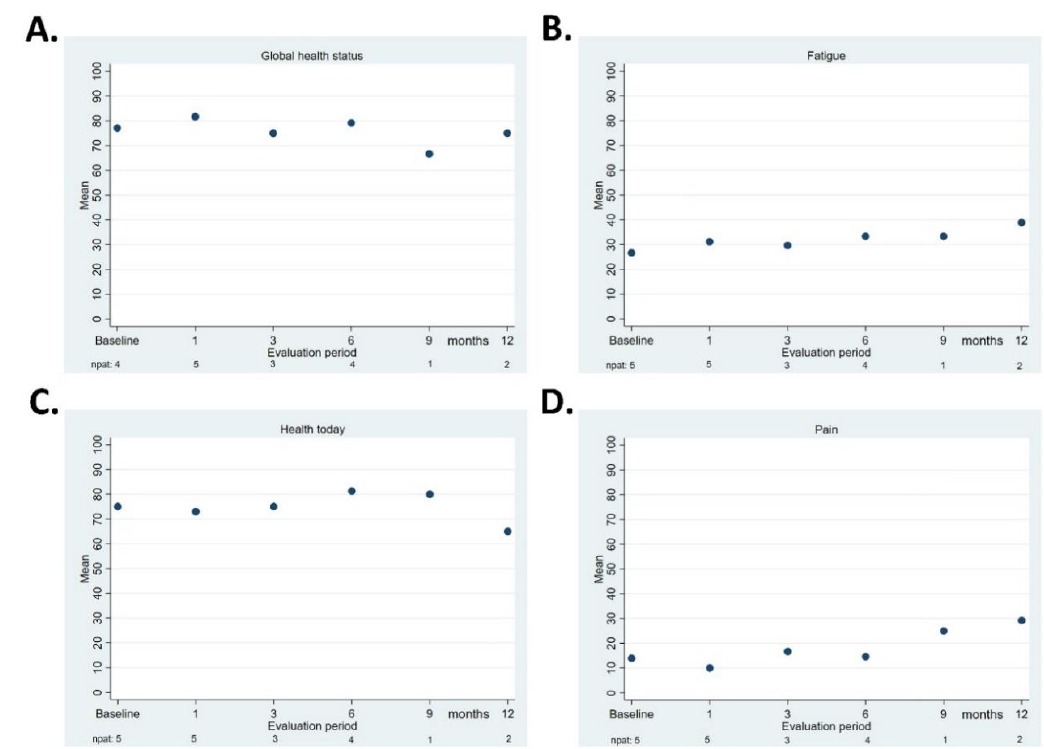
Figure 3. Quality of life, median score at each evaluation. QLQ-C30 “global health status” ( A ), EORTC QLQ-C30 “fatigue” ( B ), EuroQol-5D-5L “health today” score ( C ), and QLQ-BIL21 “pain” ( D ). The number of patients who responded is shown underneath each follow-up point.